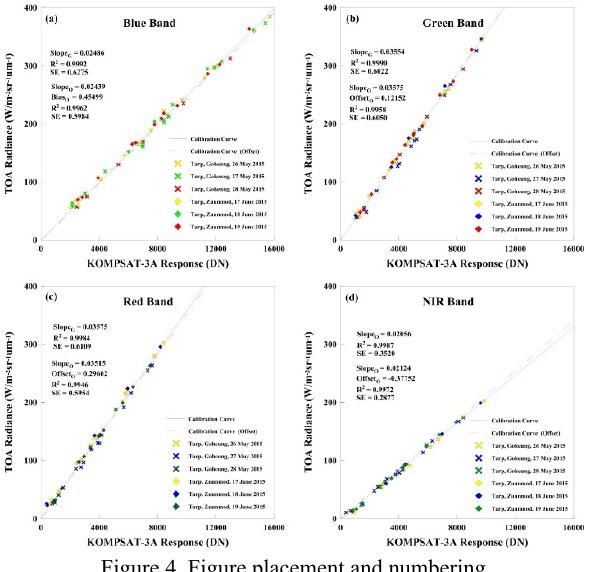
Figure 4. Figure placement and numbering